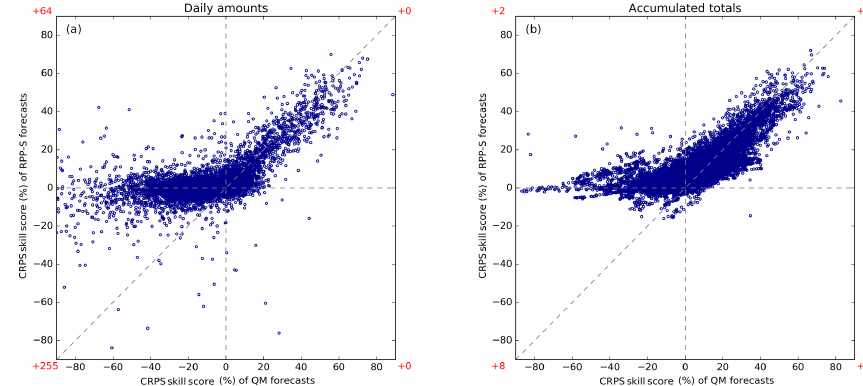
Figure 6. Scatterplots of CRPS skill scores for daily amounts (a) and accumulated totals (b) . Results for QM are on the horizontal axis and results for RPP-S are on the vertical axis. Higher CRPS skills scores reflect better forecast performance. Red text preceded by a “ + ” symbol indicates the number of points plotted outside the axis limits in the quadrant nearest the